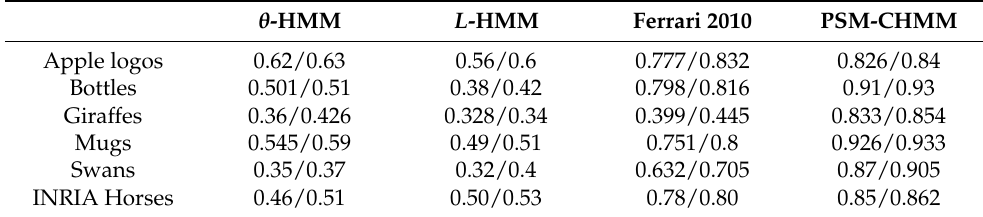
Figure 13. Comparison of DR/FPPI curves on ETHZ shape classes and INRIA Horses. Table 2. DR comparisons when FPPI =